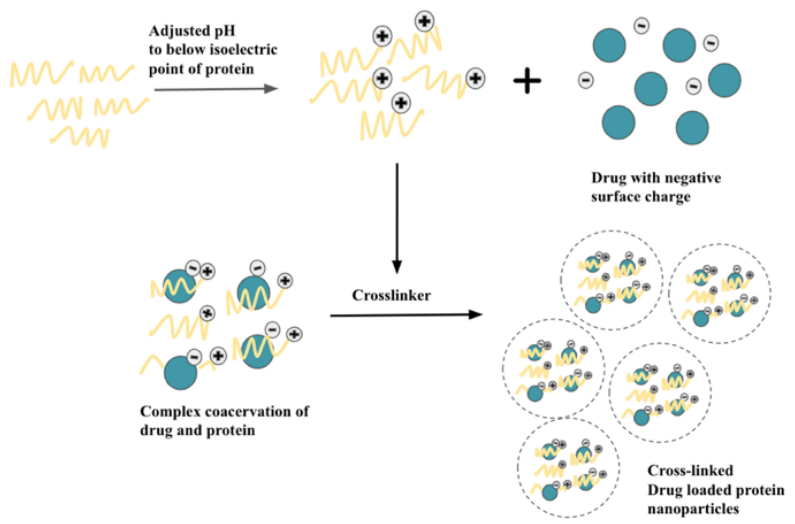
Figure 2. Complex Coacervation—This method regulates the pH to produce the protein cation or anion, and then reacts with different polymers to fabricate NPs. It involves the incorporation of natural salt or alcohol to a protein solution which changes the protein structure, to which a cross-linking material is added leading to cross-linked drug loaded protein NPs.